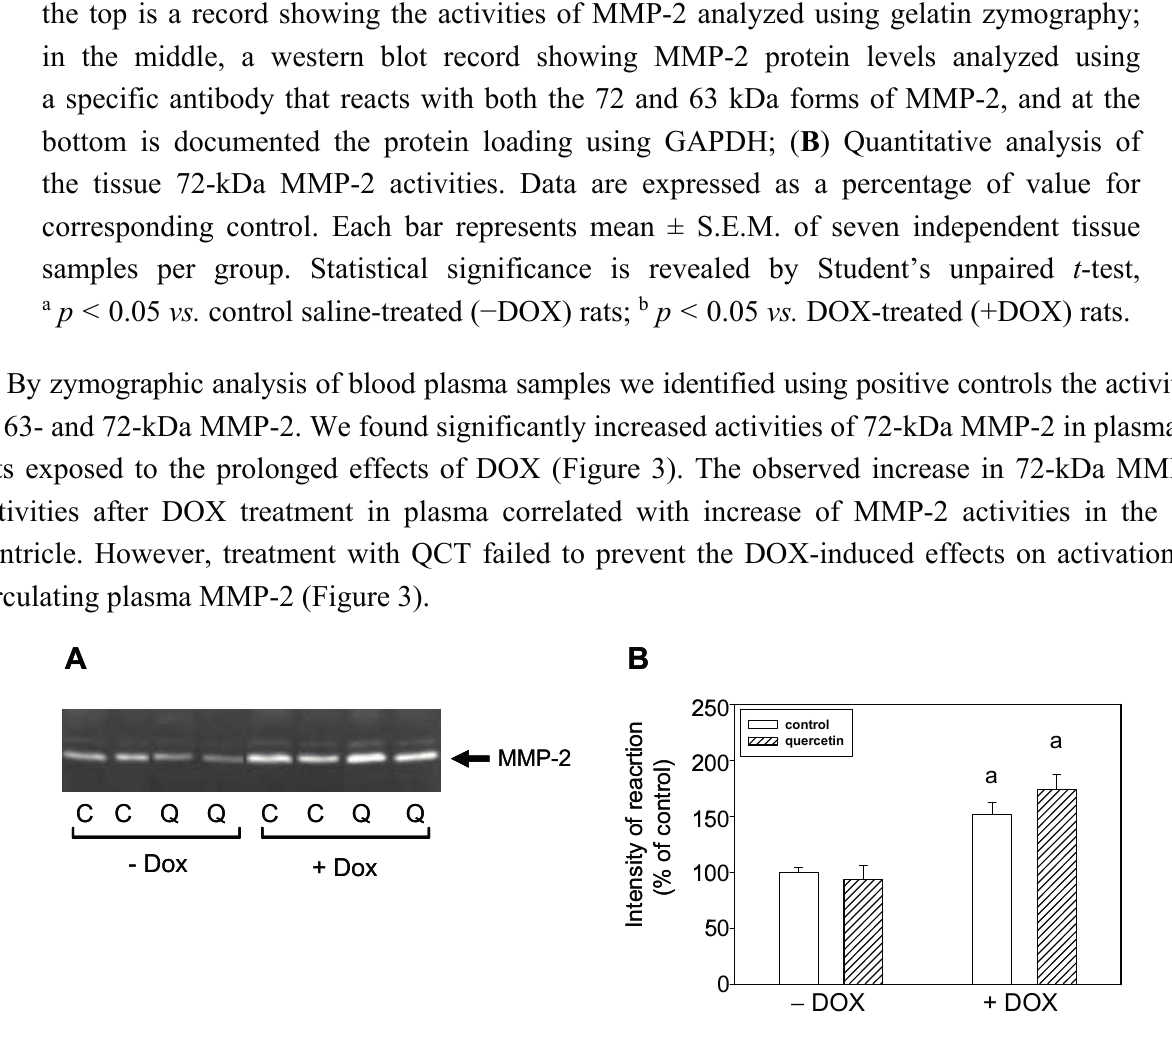
Figure 3. Effects of QCT and DOX treatment on plasma MMP-2 activities. ( A ) Zymogram showing the activities of circulating plasma MMP-2 analyzed using gelatin zymography; ( B ) Quantitative analysis of plasma MMP-2 activities. Data are expressed as a percentage of value for corresponding control. Each bar represents mean ± S.E.M. of seven independent plasma samples per group. Statistical significance is revealed by Student’s unpaired t -test, a p < 0.05 vs. control saline-treated ( − DOX)